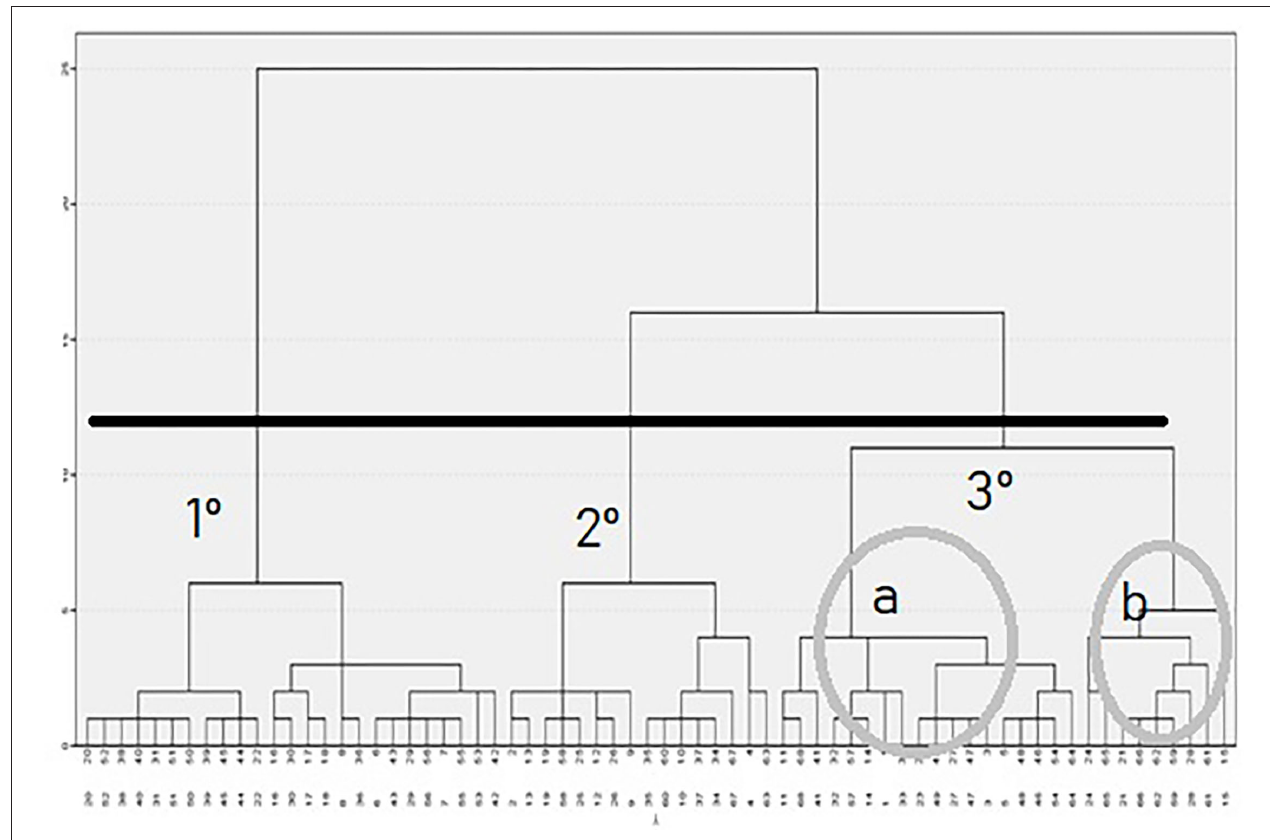
FIGURE 1 | Dendrogram groups.